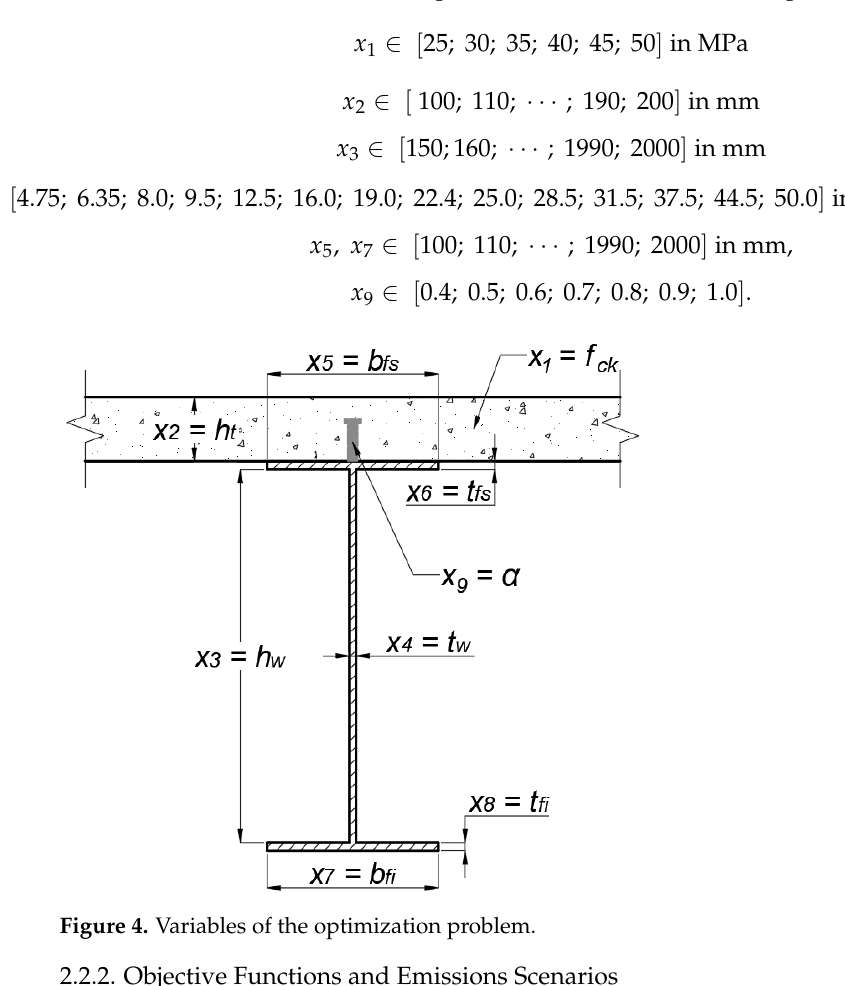
Figure 3. Longitudinal section of the pedestrian bridge.